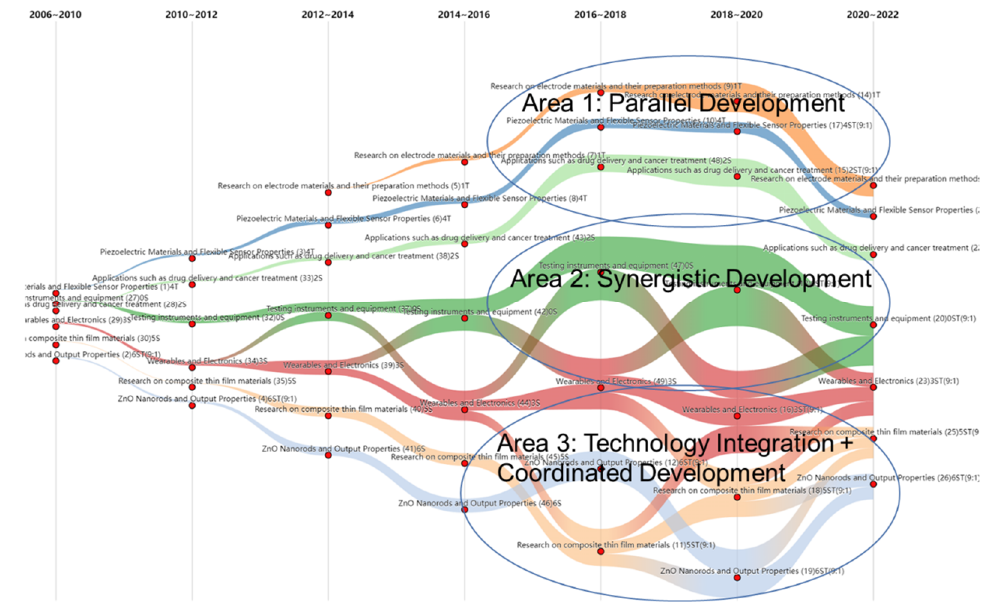
Figure 6. Evolutionary path of nanogenerator technology.